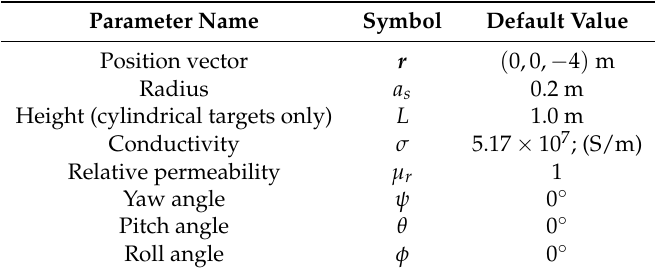
Table 3. Detected target simulation parameters and default values.